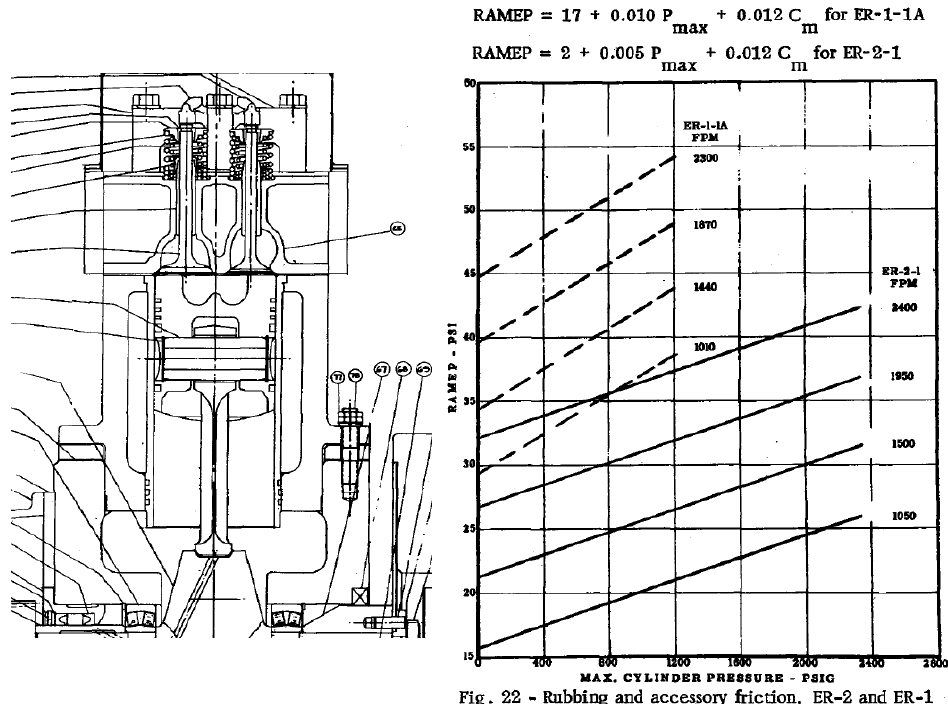
Figure A7. Snapshots taken from Chen and Flynn (1965). On the left, one of the single-cylinder engines is shown. Note that there are three compression rings per cylinder, as opposed to two piston rings for more modern engines (including ours). This will reduce the pressure loading for the top ring, because the sealing loading is shared by three instead of two rings, and will reduce the metallic contact intensity and therefore boundary friction of the ring pack. This is of course at the expense of an increase in the hydrodynamic friction. On the right, the graph shows the fMEP of the two single cylinder research engines as a function of PCP. These engines are robust, and with a short crankshaft, so they do not suffer from the torsional vibrations that our single cylinders do. Therefore, IMEP measurements are possible. Note that as the peak pressure increases, the FMEP increases as well. Note also that the slope is almost constant for all speeds, meaning that the engine speed only slightly reduces the magnitude of this loss. Note as well that the ER-1 design has higher fMEP and also higher sensitivity to peak pressure. The reasons are first that the ER2 has externally driven accessories, and second that the ER2 has a larger and heavier piston skirt that distributes the combustion load better on the cylinder liner, and also probably generates better consistency on the oil film deposited on the cylinder liner (skirt metallic contact is known to scrape off oil and generate local oil starvation conditions). The magnitude of the fMEP shown may be different on modern engines, partly due to design differences, and partly due to the single cylinder nature of these engines, but the trends persist. Note that the pressure sensitivity term of 0.005 for the ER-2 is very similar to modern engines, which typically ranges from 0.004 to 0.007 based on the design and wear state of the engine.